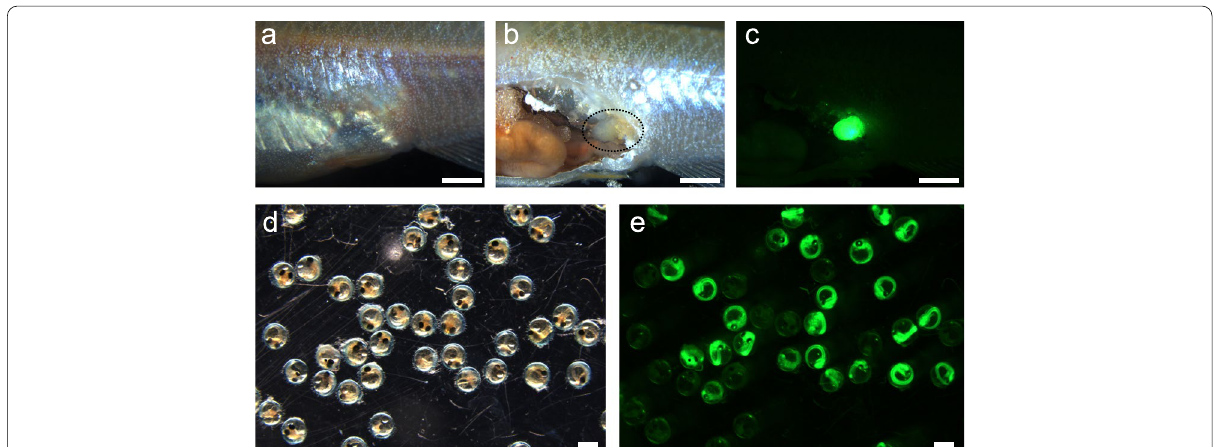
Fig. 1 The appearance and functionality of testicular tissue allografted into the abdomen of a recipient. a–c Representative images of a recipient male that received testicular tissue derived from an actb ‑GFP strain male. Bright field image of the intact abdomen a , bright field image of the incised abdomen b , and fluorescence image of the incised abdomen c ; transplanted location is encircled by a dotted line in panel b ; scale bar, 1 mm. d, e Representative images of the eggs fertilized by the recipient male that had been transplanted with testicular tissue of an actb ‑GFP strain male. Bright field image d and fluorescence image e ; scale bar, 1 mm